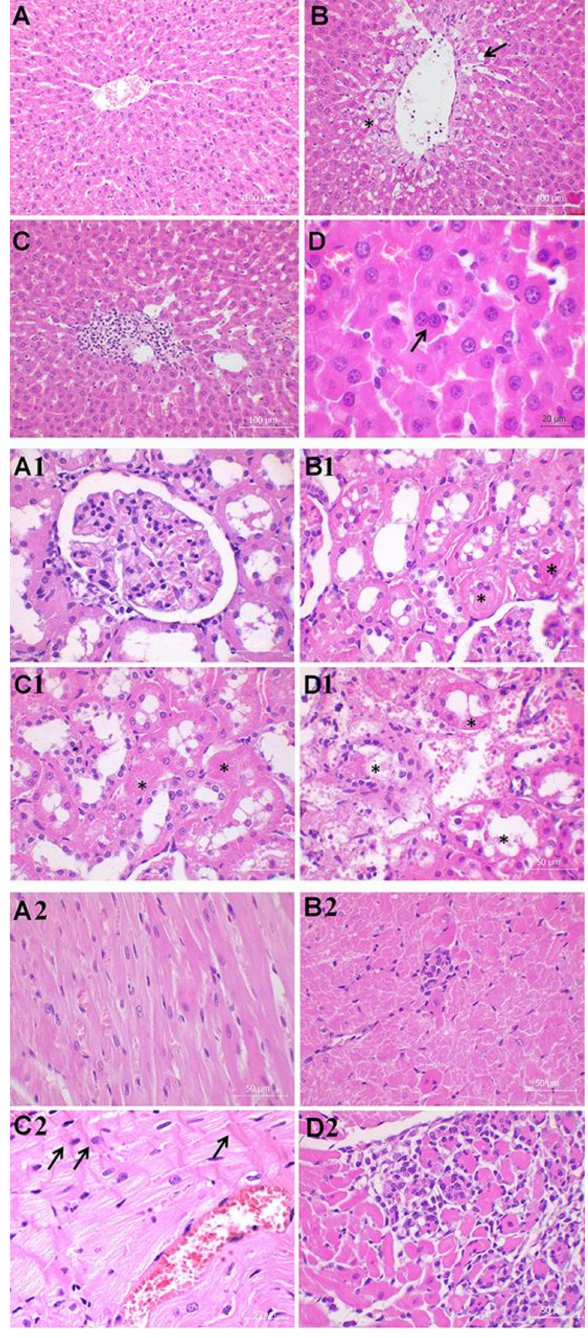
Figure 2. Liver histology analysis (40 × and 60 × ). Group categories abbreviations: ( A ) control ( C ) rat group; ( B , C ) sepsis (S) rat group; (D) meldonium + sepsis (M + S) rat group. Results of liver analysis: ( A ) Normal histological structure of the hepatic tissue; ( B ) The black asterisk indicates the parenchymal vacuolization owing to the hydropic degeneration and cytoplasm swelling of the hepatocytes. The black arrow indicates steatosis; ( B , C ) Micrography presents necrosis of larger groups of hepatocytes (patchy necrosis) and sinusoidal congestion with the extravasation of erythrocytes; ( D ) The black arrow indicates binucleation of hepatocytes. Kidney histology analysis (40 × ). Group categories abbreviations: ( A1 ) control (C) rat group; ( B1 ) sepsis (S) rat group; ( C1,D1 ) meldonium + sepsis (M + S) rat group. Results of kidney analysis: (A1) Normal histological structure of glomeruli and tubules; ( B1 ) Micrography displays moderate kidney damage with the reduction or complete loss of the epithelial brush border. The black asterisk indicates rare bleb formation; ( C1 , D1 )